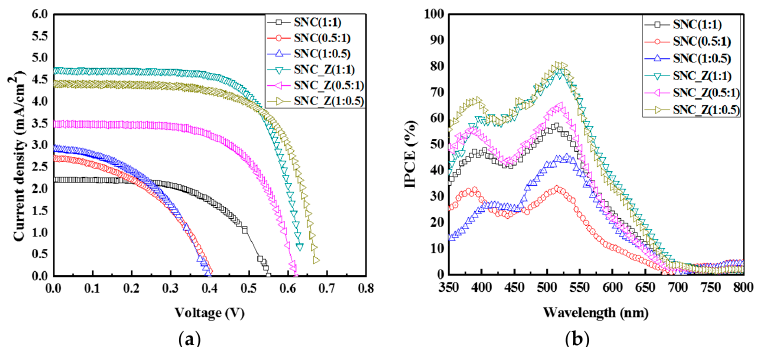
Figure 4. ( a ) I ‐ V characteristic curves; and ( b ) photo ‐ to ‐ current conversion efficiency ( IPCE ) curves of the dye ‐ sensitized solar cells (DSSCs) based on different photoanodes.